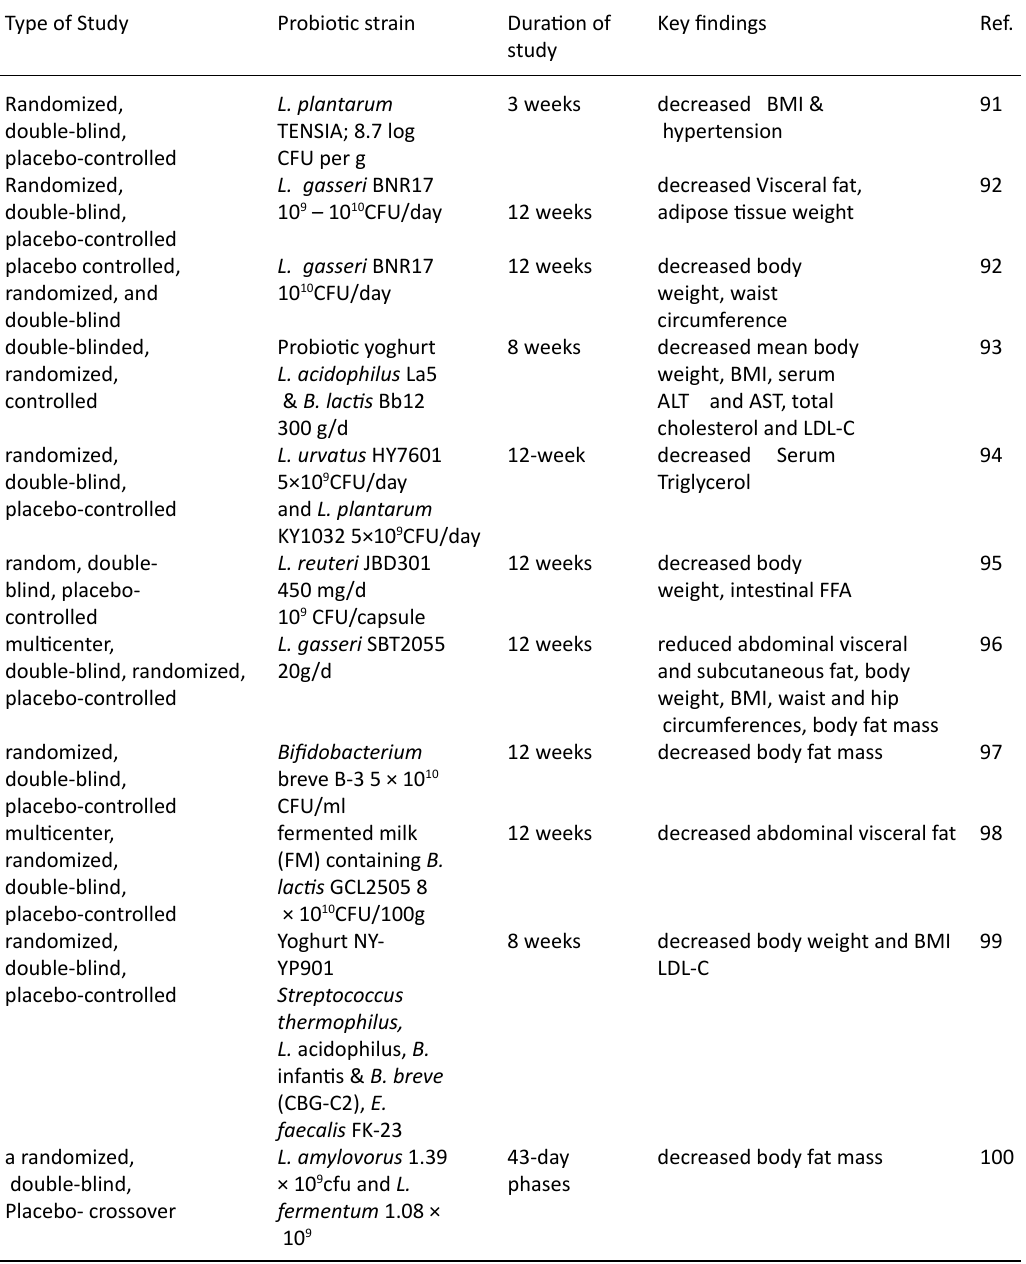
table 2. Clinical trials of probiotics in treatment of obesity Type of Study Probiotic strain Duration of Key findings Ref.